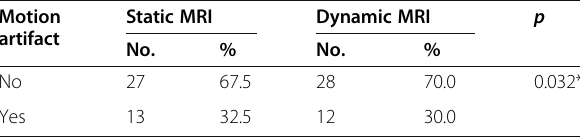
54 joints with normal condylar translation, 18 joints with hypomobile condylar translation, and 8 joints with hypermobile condyles ( p value < 0.001). The ability of Table 4 Motion artifact in static and dynamic MRI in the studied patients ( n = 40) Motion